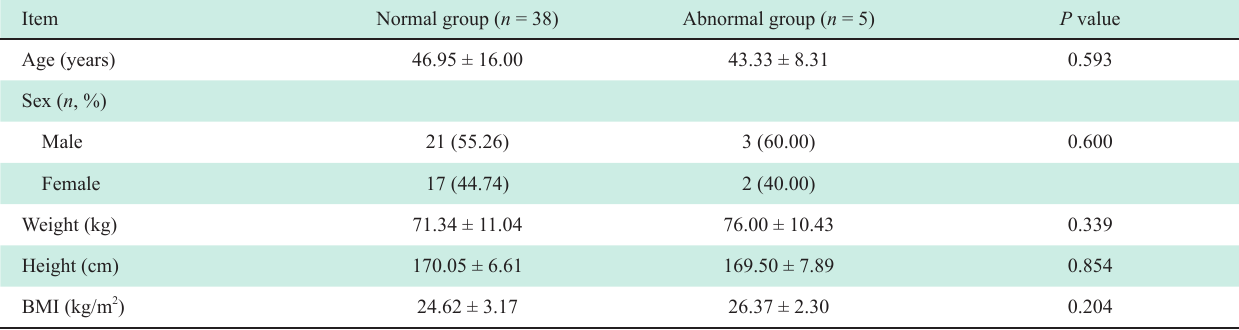
Table 1 Clinical information of the patients in the normal and abnormal groups